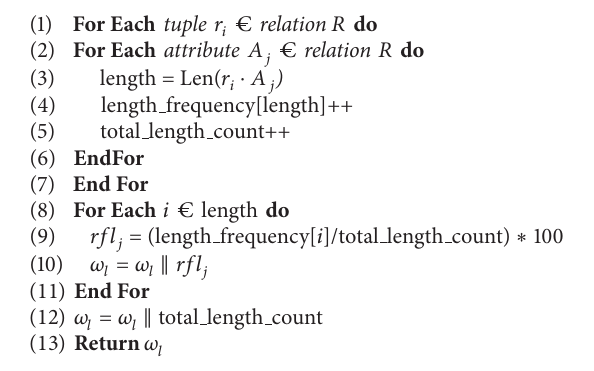
Algorithm 2: Digit sub-watermark generation. Table 1: Notations.